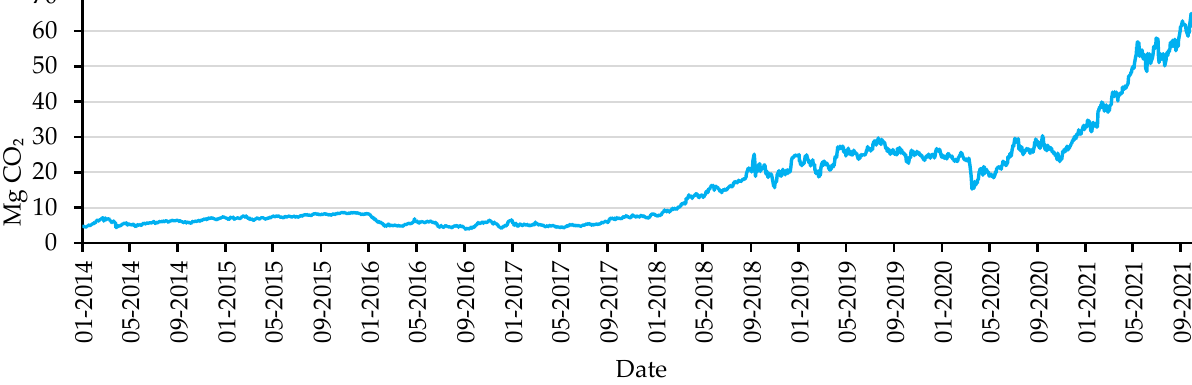
Figure 1. Prices of CO 2 emission allowances in 2014–2021. Authors’ study based on [26]. Analysing the current situation on the photovoltaic market in European countries with a temperate climate, Poland, immediately after Germany and The Netherlands, has the largest PV market [27]. With an estimated annual insolation value of 1000 kWh/m 2 [28,29], the Polish photovoltaic sector is the fastest-developed renewable energy sector—with a total capacity of micro-installations of 4075.5 MW (data as of 31 June 2021). Comparing this with the total installed capacity as of 30 June 2017, it indicates almost a 25-fold increase in less than 4 years (Figure 2) [30]. As a result, Poland ranks fifth in terms of creating new PV installation capacities, closely behind Germany, Spain, The Netherlands, and France. Forecasts show that PV installations will continue to be popular in the future, and installed capacity may, with conservative estimates, increase by around 5–7 GWp by 2030 [31] and by around 10–16 GWp by 2040 [32,33].